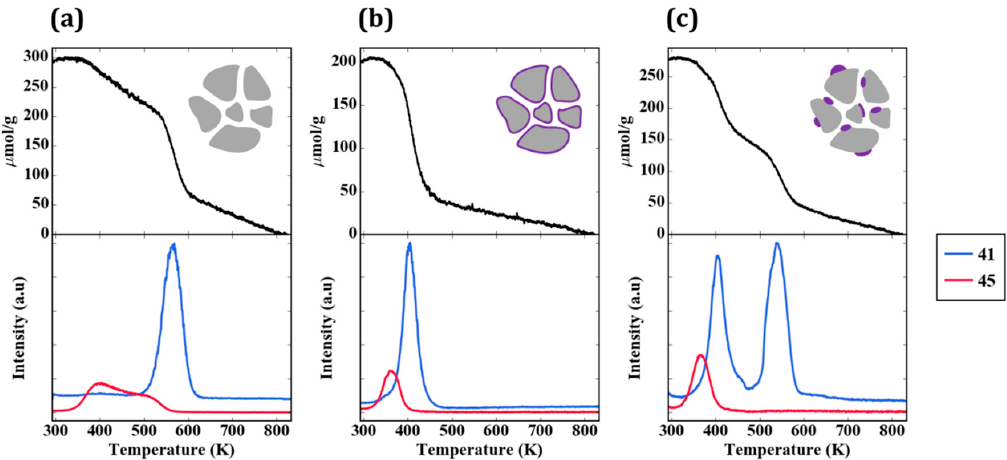
Figure 4. TPD-TGA of 2-propanol over ( a ) ZrO 2 , ( b ) 5W-Zr, and ( c ) impW-Zr. The desorption features correspond to propene ( m / e = 41) and unreacted 2-propanol (m / e = 45). The graphic symbols are a schematic of the WO x (purple) over the ZrO 2 support (gray).